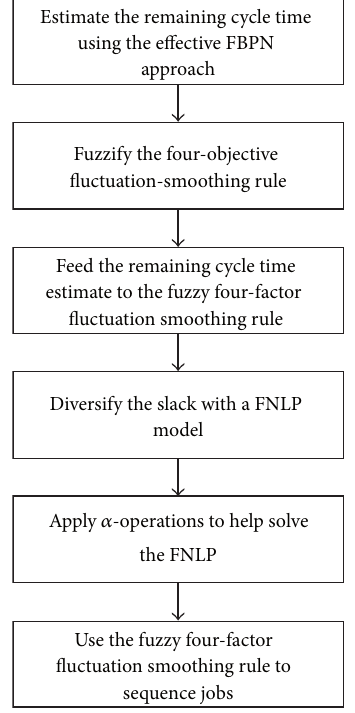
Figure 1: The flowchart of the proposed